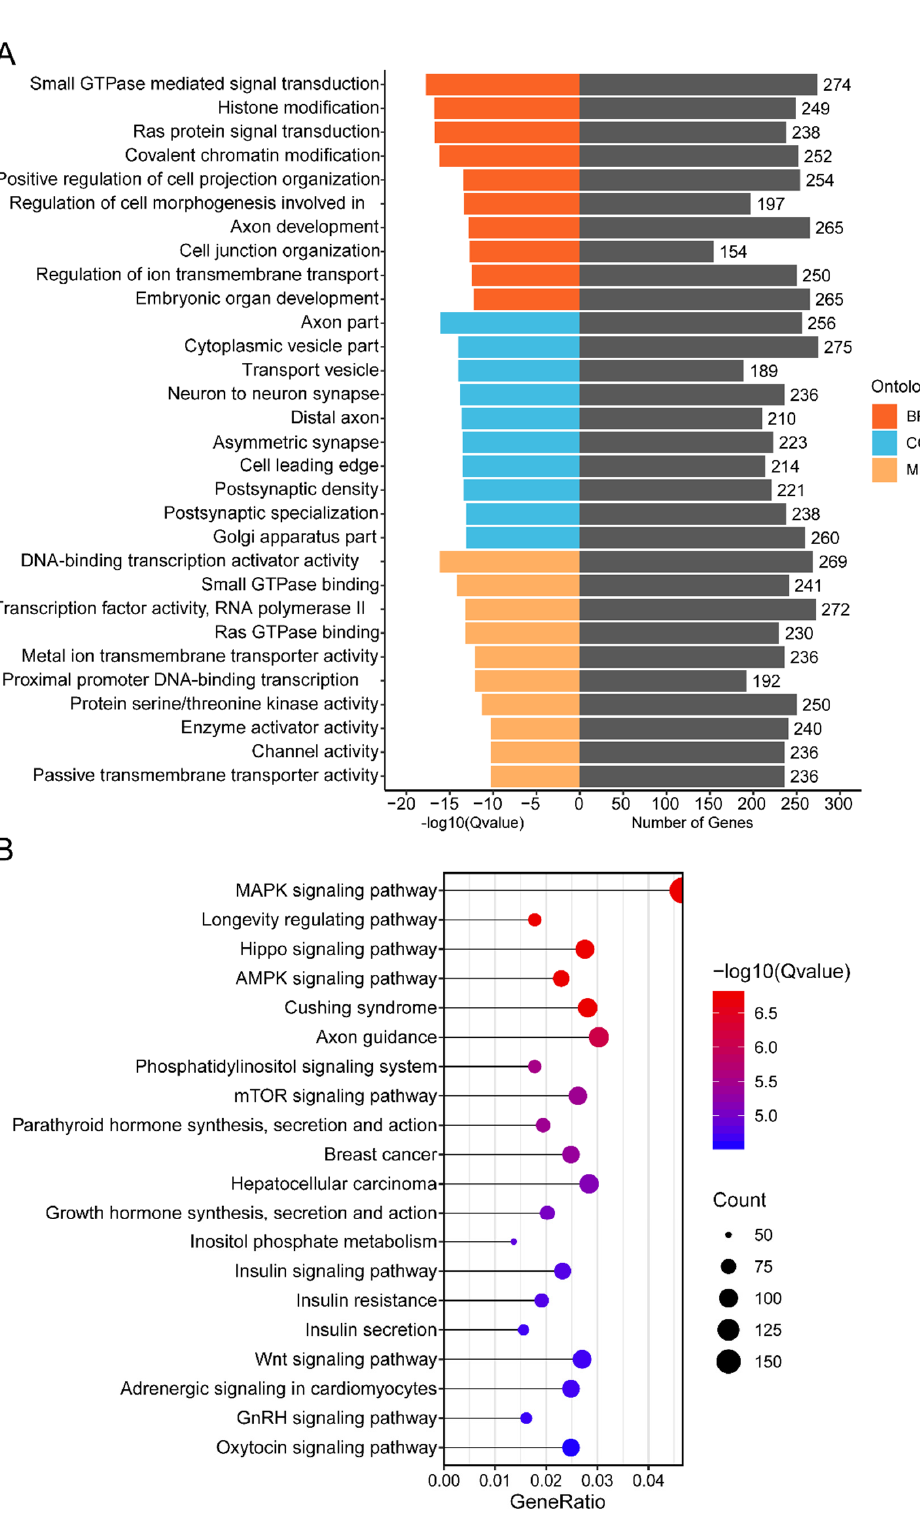
Figure 4. GO and KEGG enrichment analysis of cluster 1 miRNAs’ target genes: ( A ) GO term enrichment analysis of cluster 1 miRNAs’ target genes, including biological process (BP), cellular component (CC), and molecular function (MF). ( B ) KEGG pathway analysis of cluster 1 miRNAs’ target genes. The size of the circle represents the number of genes enriched in the pathway, and the color scale from blue to red (more significant enrichment) represents the enriched significance.